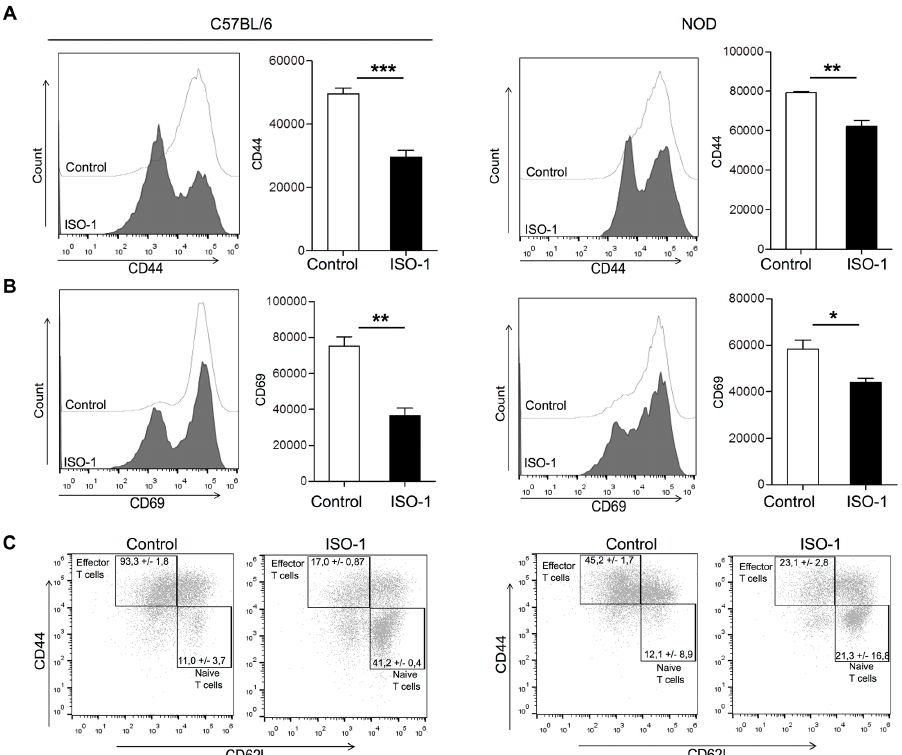
Fig 6. ISO-1-treated NOD- or C57BL/6-macrophages modulate T cell activation in vitro . (A-C) Ctr- or ISO-1-treated macrophages isolatedfrom either C57BL/6or NOD mice (5 × 10 4 cells/well)were washed before addition of OVA 323-339 peptideor BDC2.5 mimotope (1 μ g/mL) and culturingtogether with negatively isolatedCD4 + T cells from OT-II or BDC2.5 Tg mice (1 × 10 5 cells/well). The activationstatus of the co- culturedT cells was measuredby flow cytometric analysisof the mean fluorescence intensity (MFI) of CD44 and CD69expressionon viable CD4 + T cells after 3 days in co-culture (mean ± SEM) (n = 4) ( * , p < 0.05; ** , p < 0.01, *** p (cid:20) 0.005). (C) To identify na ï veT cells (definedas CD44 low CD62L high ), memory T cells (defined as CD44 high CD62L high ) and effector T cells (CD44 high CD62L low ), multi-color flow cytometry was performed and the frequenciesof these populationswere quantified. (C) In CD4 + cells, the percentages of effector T cells significantly decreased in the presenceof ISO-1-conditionedmacrophages, whilena ï veT cells remained prominently visiblecomparedwith the control condition.A p-value < 0.05 indicatesignificantdifferences betweengroups (n = 4). The data shown are representative of four independent experiments.